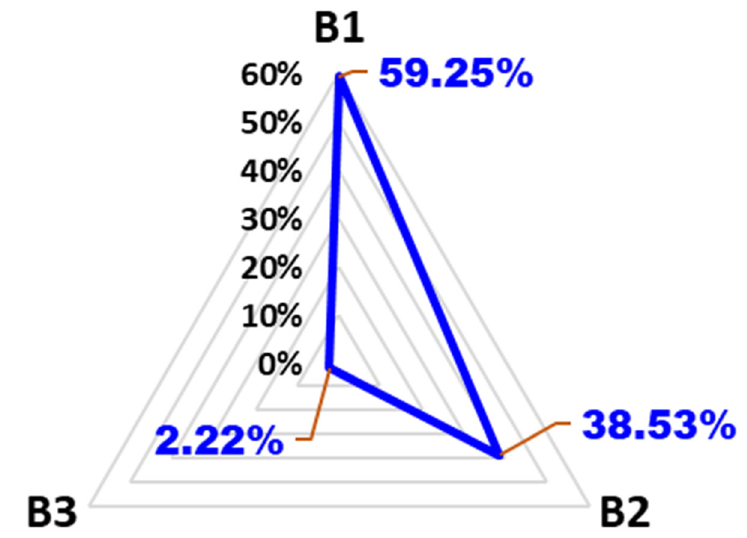
Figure 6. Percentage of presence by type of building.